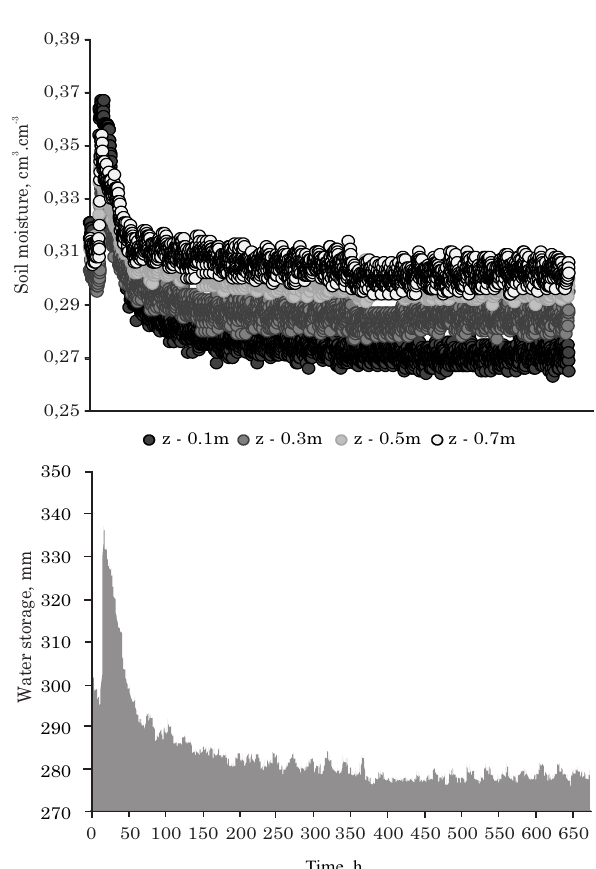
Figure 3. Distribution of average moisture in the